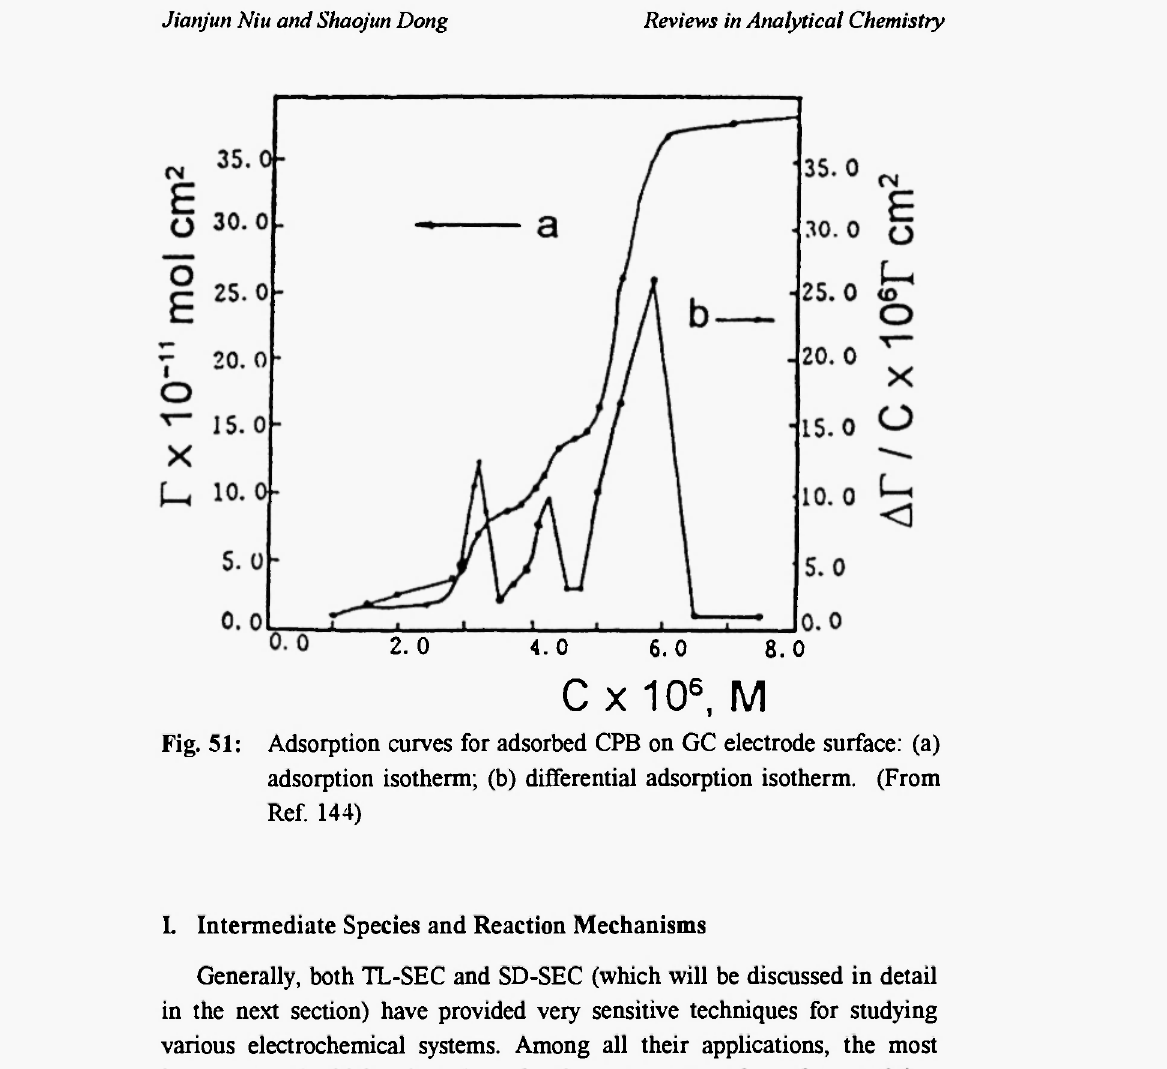
Fig. 51: Adsorption curves for adsorbed CPB on GC electrode surface: (a) adsorption isotherm; (b) differential adsorption isotherm. (From Ref.